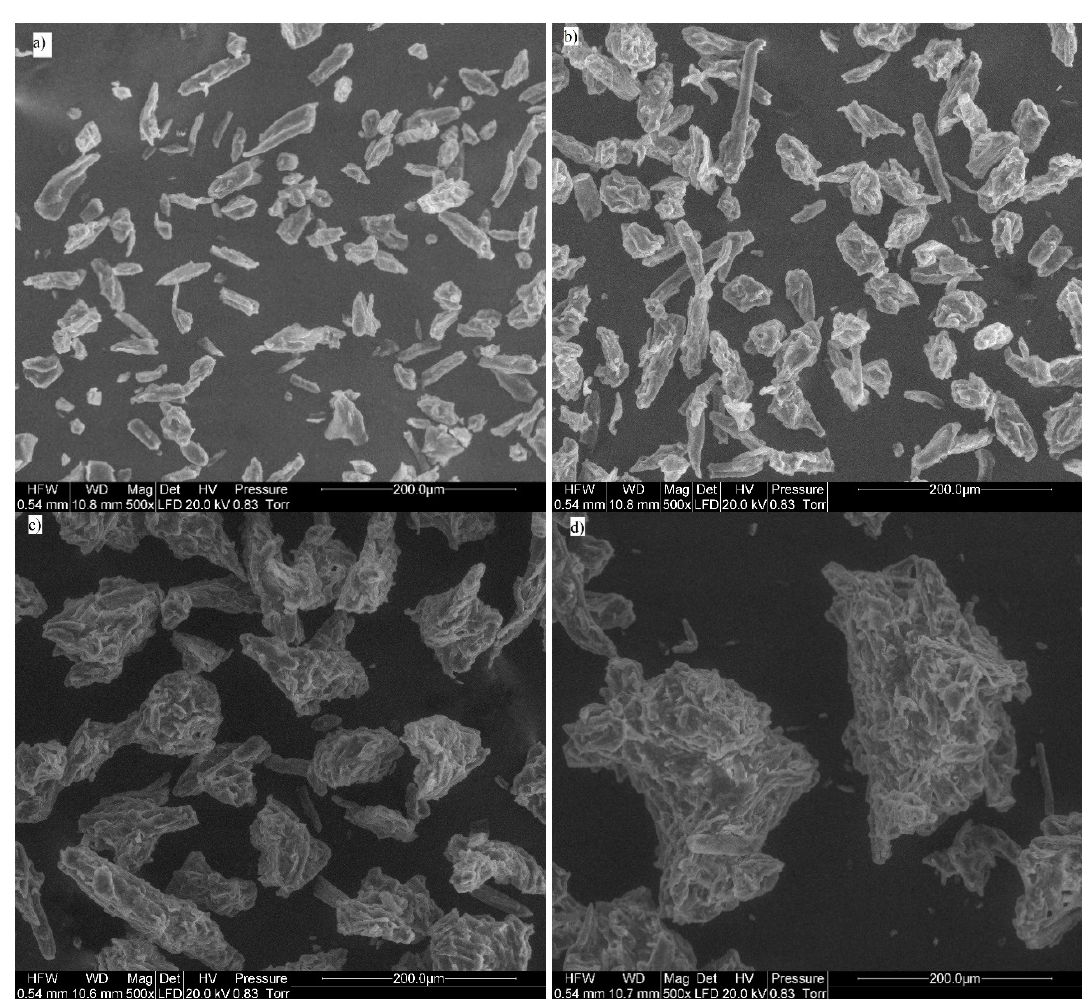
Figure 1. SEM micrographs of MCC particles with sizes of ( a ) 20–32 μ m; ( b ) 32–45 μ m; ( c ) 56–100 μ m; ( d ) 150–212 μ m.